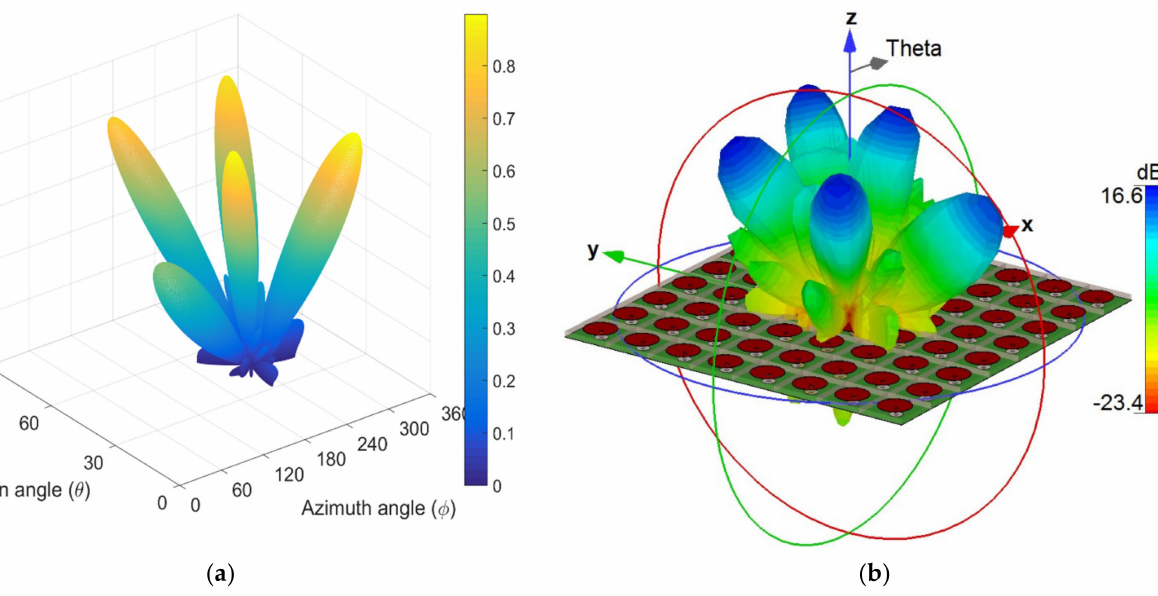
Figure 9. 3D beam steering of the proposed beamforming scheme using an 8 × 8 planar array: ( a ) the linear simulation scale in MATLAB; ( b ) the dB simulation scale in